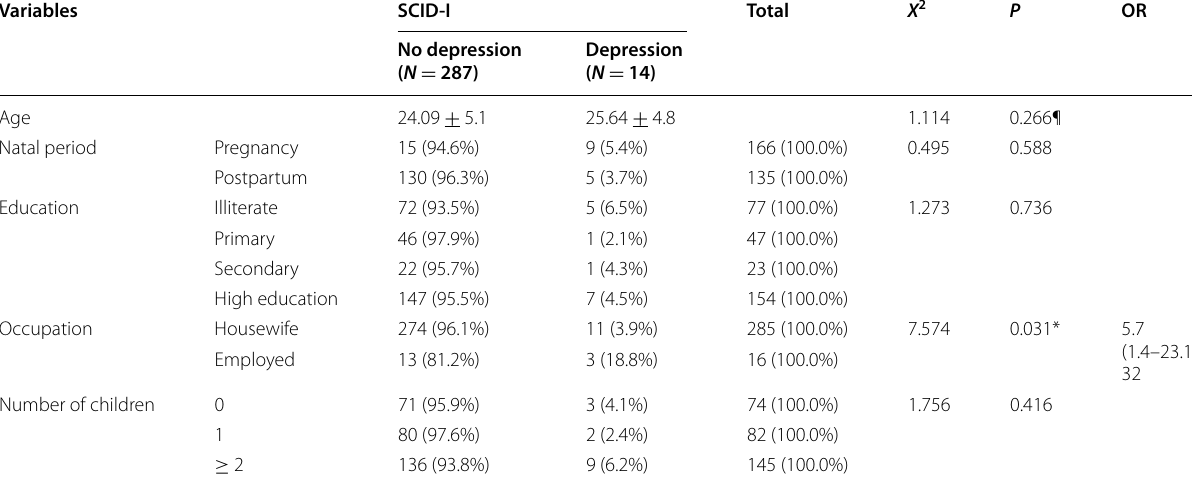
SCID-I the Structured Clinical Interview for DSM-IV; ¶independent t -test; *statistically significant